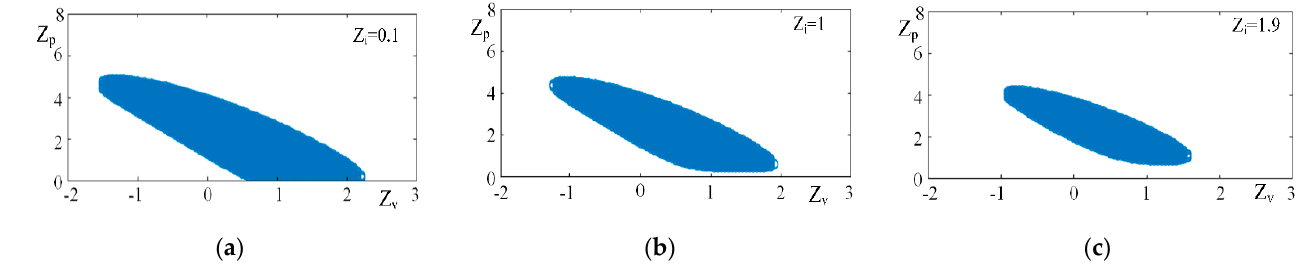
Figure 5. Stability region diagram under the influence of parameters Z i . ( a ) Z i = 0.1; ( b ) Z i = 1; ( c ) Z i = 1.9.